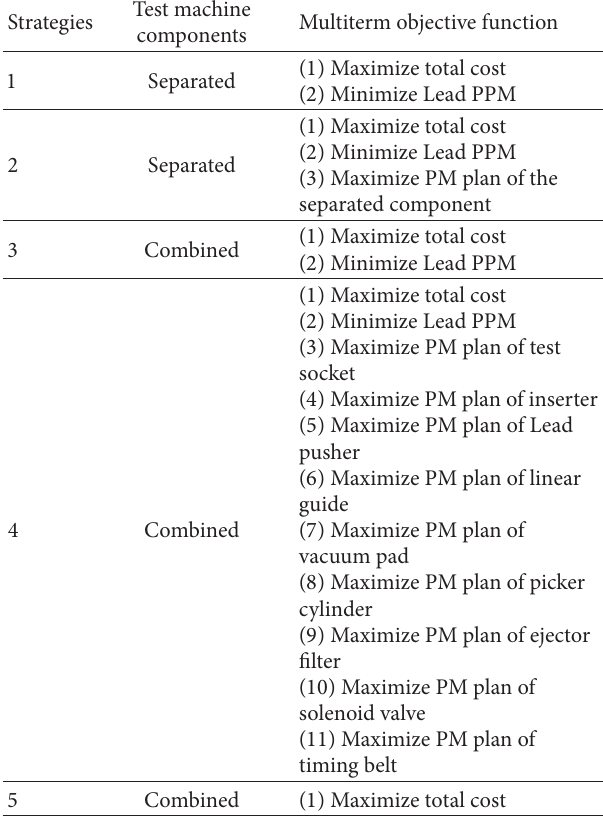
Table 12: Overall scenarios of RCM